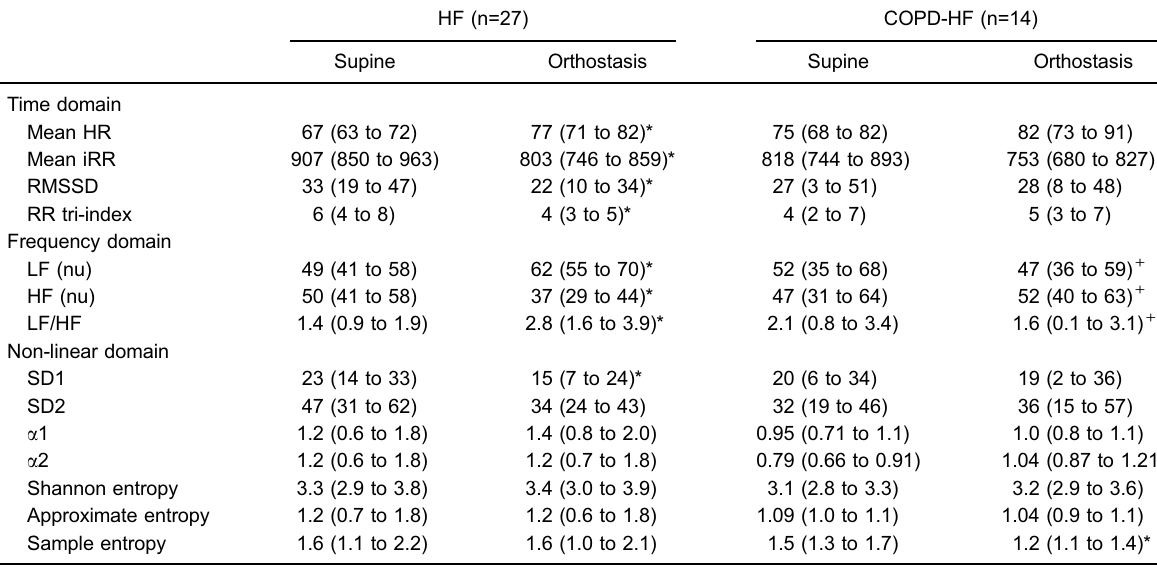
Table 2. Heart rate variability indices during active postural maneuver in heart failure (HF) patients and chronic obstructive pulmonary disease-heart failure (COPD-HF)